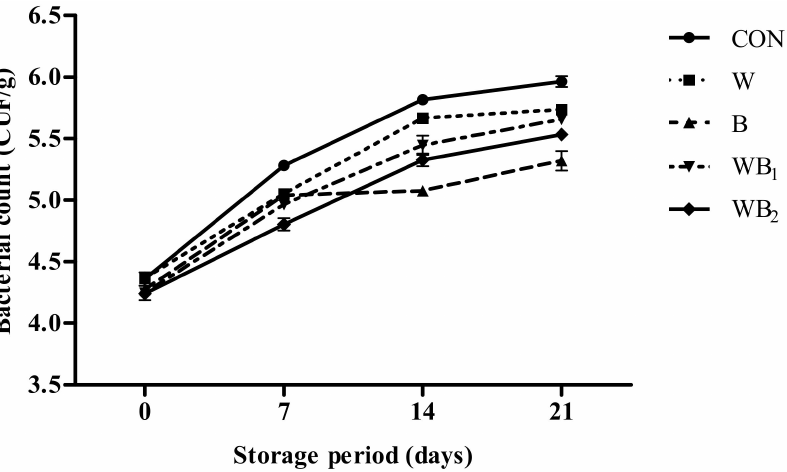
Figure 4. E ff ect of B. serrata and whey powders on the number of aerobic bacteria in pork patties during storage. Error bars indicate standard deviations. CON ( • ), control (no additive(s)); W ( (cid:4) ), addition of 2% whey powder; B ( (cid:78) ), addition of 0.5% B. serrata powder; WB 1 ( (cid:72) ), addition of 2% whey powder and 0.5% B. serrata powder; WB 2 ( (cid:7) ), addition of 2% whey powder and 1% B. serrata